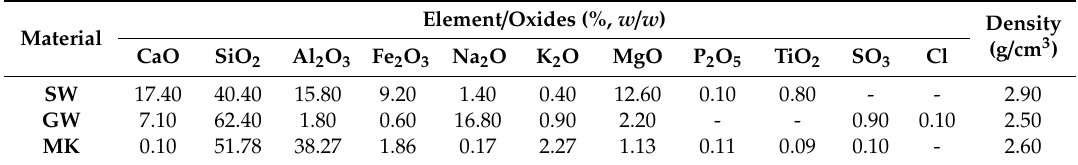
Table 1. The chemical compositions and densities of SW, GW, and MK.